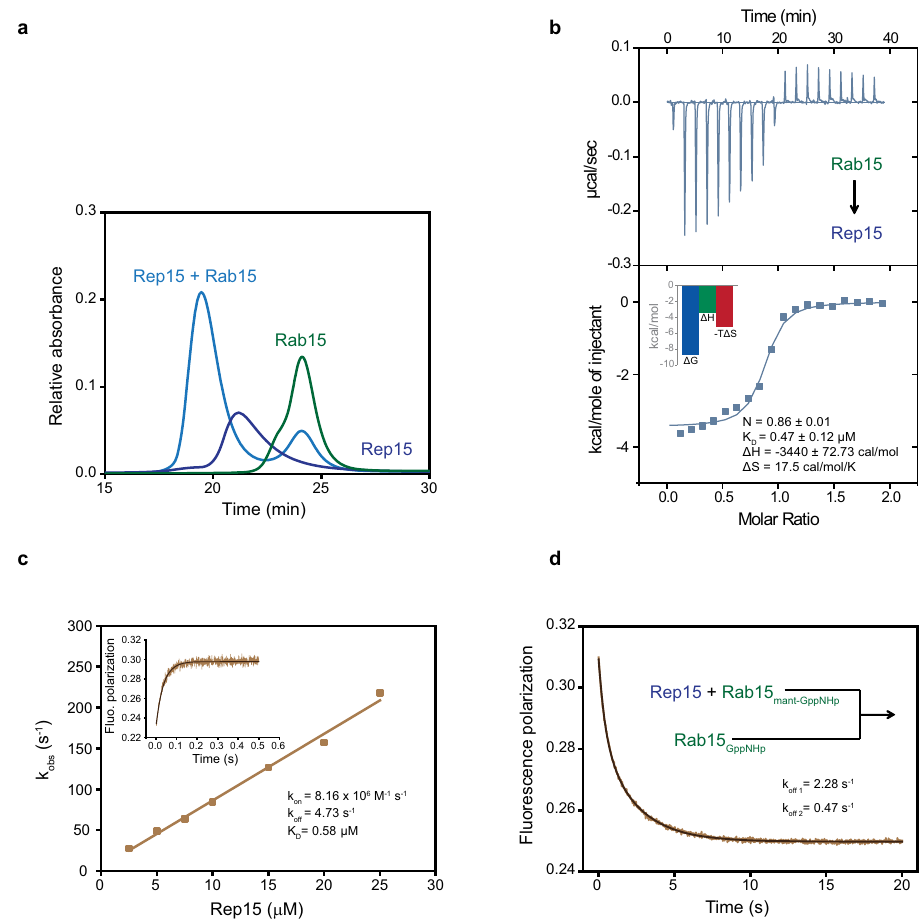
Fig. 1 Biochemical characterization of Rep15:Rab15 interaction. a Interaction of Rep15 with Rab15 GppNHp was analyzed by analytical size exclusion chromatography. 110 µ M of Rep15 (blue), 121 µ M of Rab15 GppNHp (green) and the mixture of both (sky blue) is loaded on a Superdex 75 10/300 GL column. A clear complex formation was observed. The curves shown are representative of at least three experiments. b ITC measurement of Rep15 (50 µ M) titrated with 500 µ M of Rab15 GppNHp . Heat peaks were integrated and fi tted to a one-site-binding model yielding the binding stoichiometry (N), the enthalpy ( Δ H), the entropy ( Δ S) and the dissociation constant (K D ). The data are representative of at least three repetitions. c Association rate constant ( k on ) for the Rab15 mant-GppNHp (0.5 µ M) interaction with the different concentration of Rep15 (2.5 – 25 µ M). Association was monitored by the change in fl uorescence polarization using a stopped- fl ow apparatus at 25 °C. Association of the Rep15 with Rab15 fl uorescence mant-GppNHp leads to an increase in polarization and data is fi tted to a single exponential. The change in fl uorescence polarization of 1 μ M Rab15 mant-GppNHp upon 15 μ M Rep15 binding is shown in the inset. d Dissociation of Rab15 from the Rep15 was determined by monitoring the decrease of fl uorescence polarization after mixing a complex of Rep15:Rab15 mant-GppNHp (2 μ M) with a 25-fold excess of non fl uorescent Rab15 GppNHp and data is fi tted to a double exponential. Data analyzed are averages of 6 – 8 individual